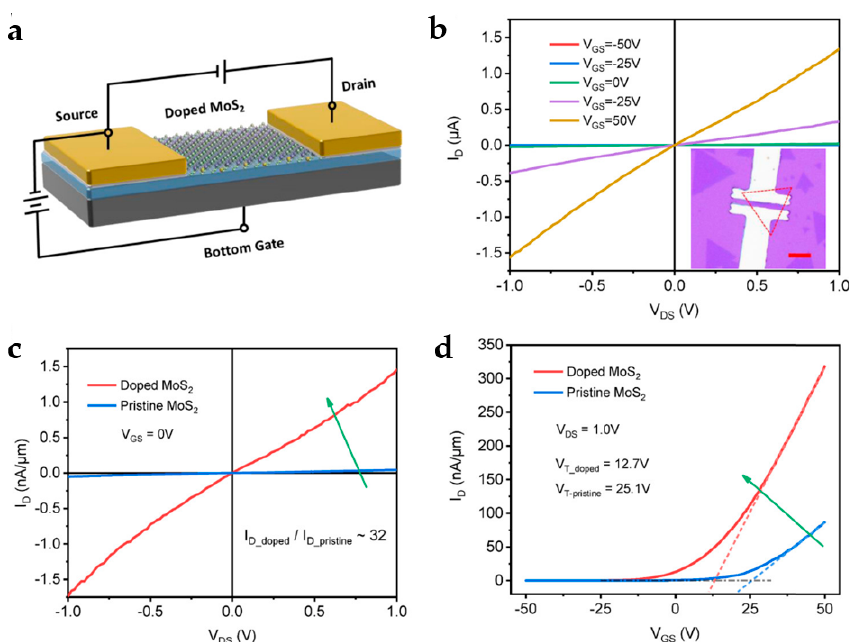
Figure 11. Electrical characteristics of a doped MoS 2 PD. ( a ) Schematic diagram of the construction of the doped MoS 2 PD and its electrical connections. ( b ) Output curve of the transistor in dark environment (V GS = − 50~50 V). Illustration shows an optical microscope image of a doped MoS 2 PD with a 10 µm scale (red). ( c ) Output curve (V GS = 0 V) and ( d ) transfer curve of doping and original MoS 2 FETs in the dark (V DS = 1.0 V). The green arrow shows that the drain current of the FETs based on the doped MOS 2 is higher than that of the pristine MoS 2 . (Reprinted with permission from ref. [141] . Copyright 2019 American Chemical Society Publications).